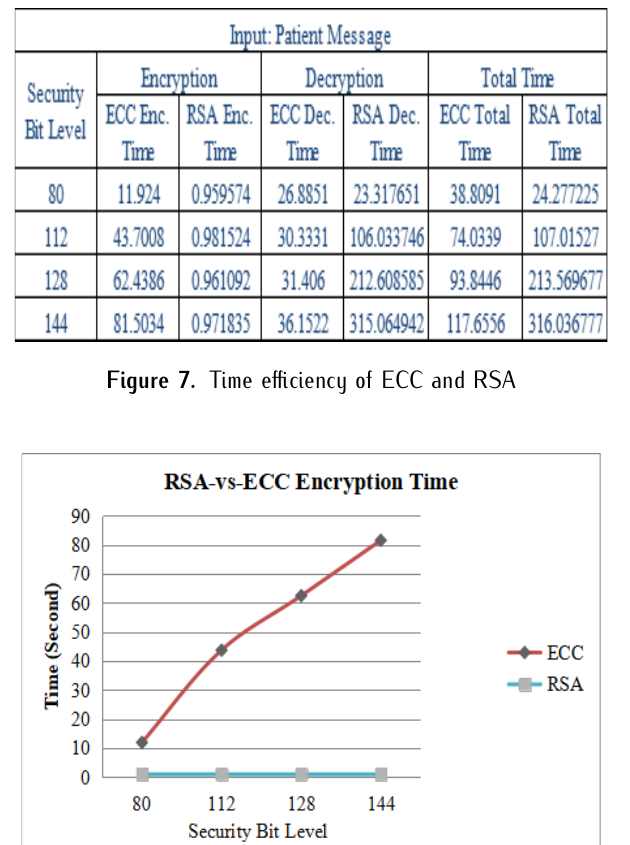
Figure 8. Encrytion time (in sec.) of ECC and RSA